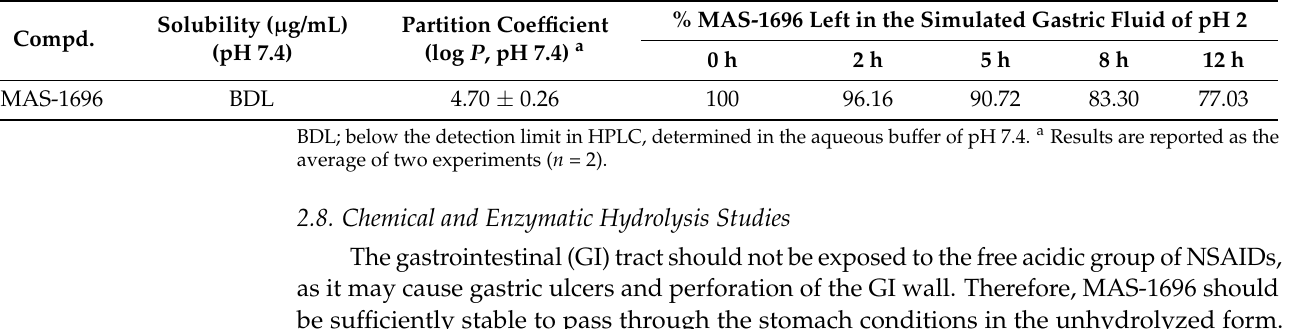
Table 3. Aqueous solubility, partition coefficient (log P), and chemical stability of MAS-1696.